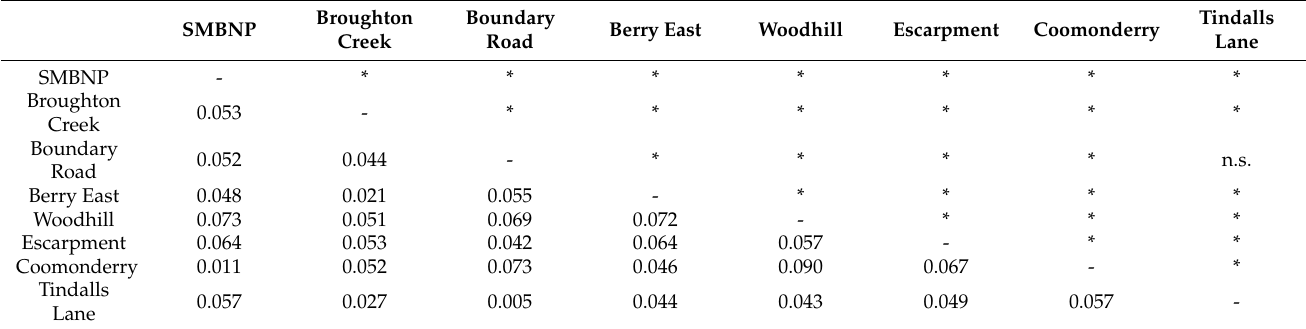
Table 3. Pairwise population F ST values between sugar glider sampling locations (below the diagonal), and significant comparisons were Bonferroni corrected. *: p < 0.0017; n.s.: p > 0.0017.